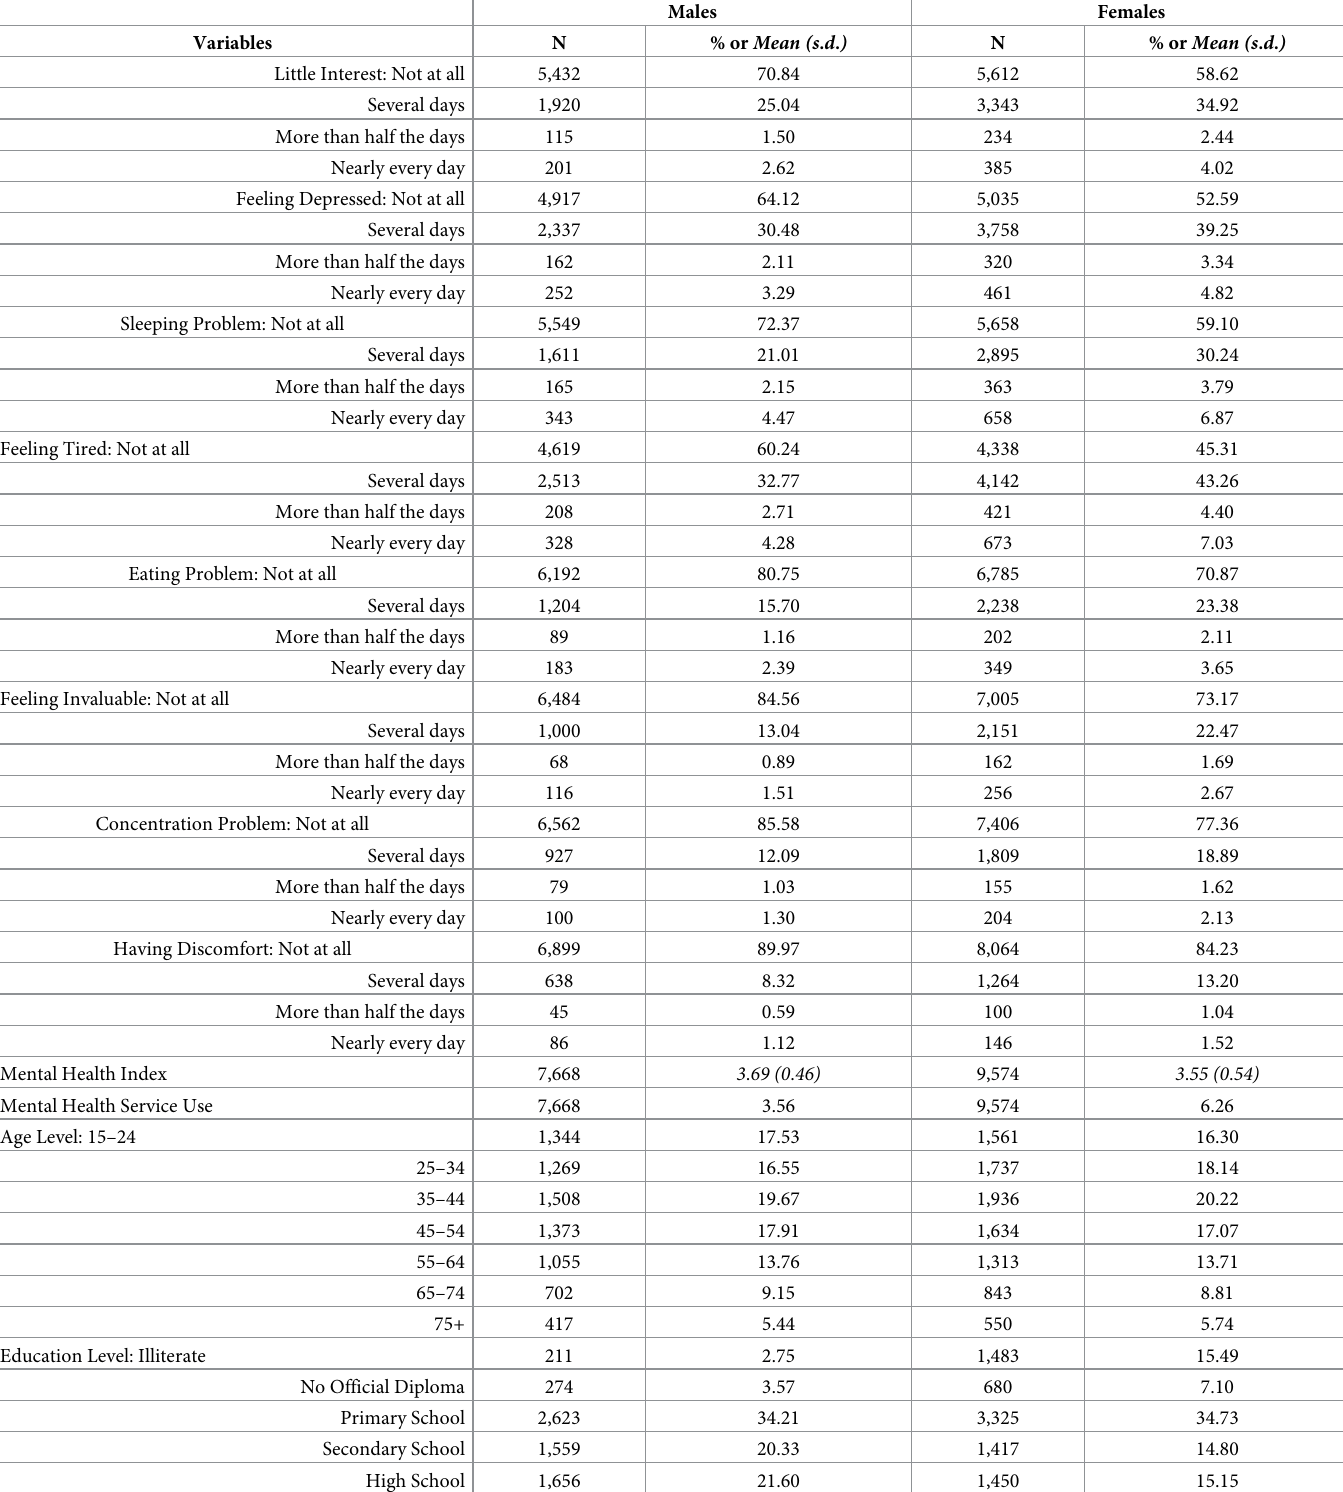
Table 2. Frequency distributions of variables across gender. Males Females Variables N % or Mean (s . d . ) N % or Mean (s . d .